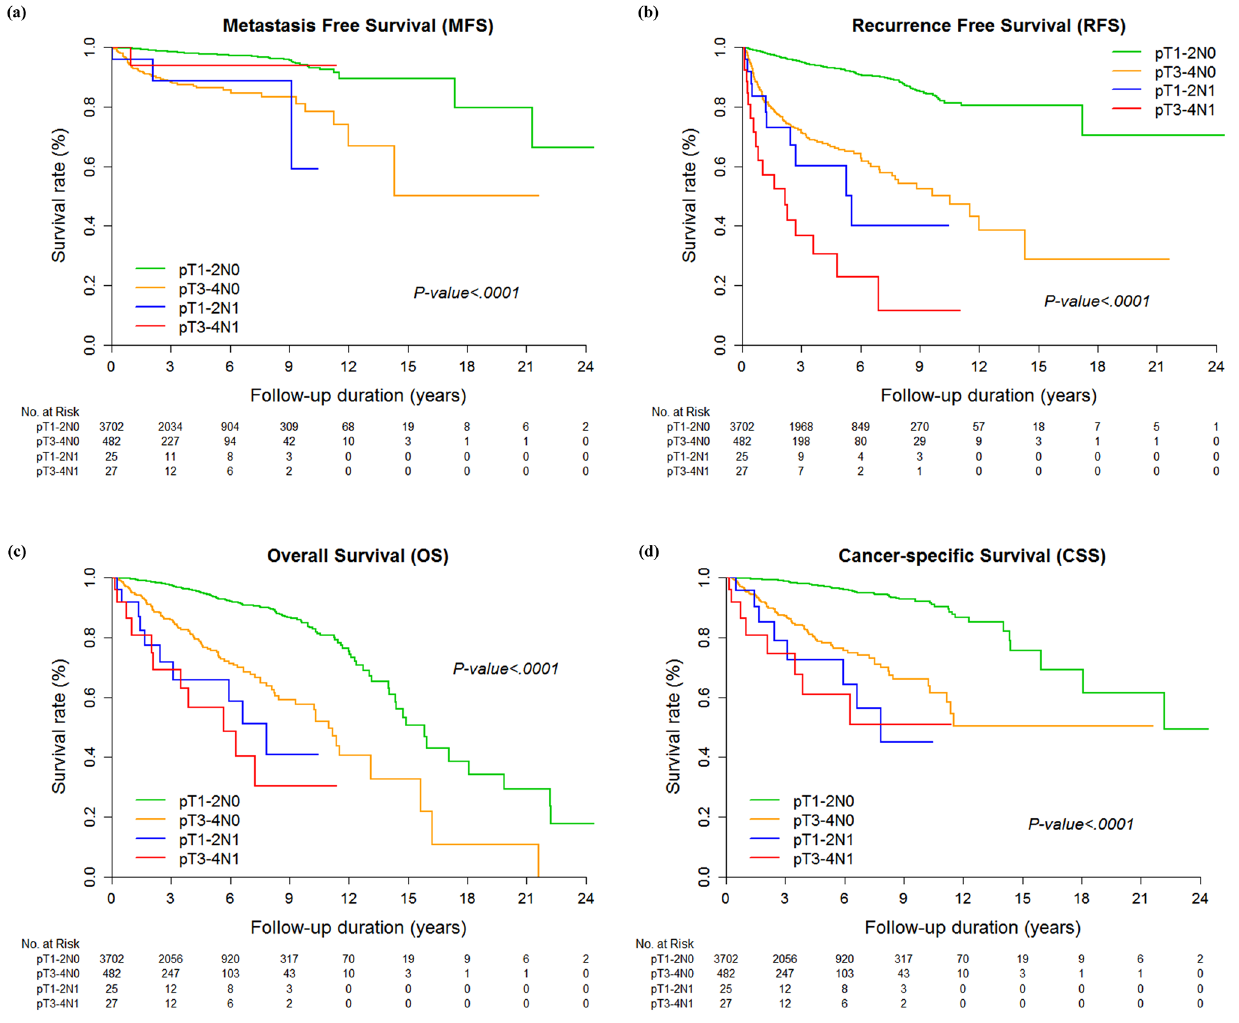
Figure 2. Kaplan–Meier curves for ( a ) MFS, ( b ) RFS, ( c ) OS, and ( d ) CSS in four pTN